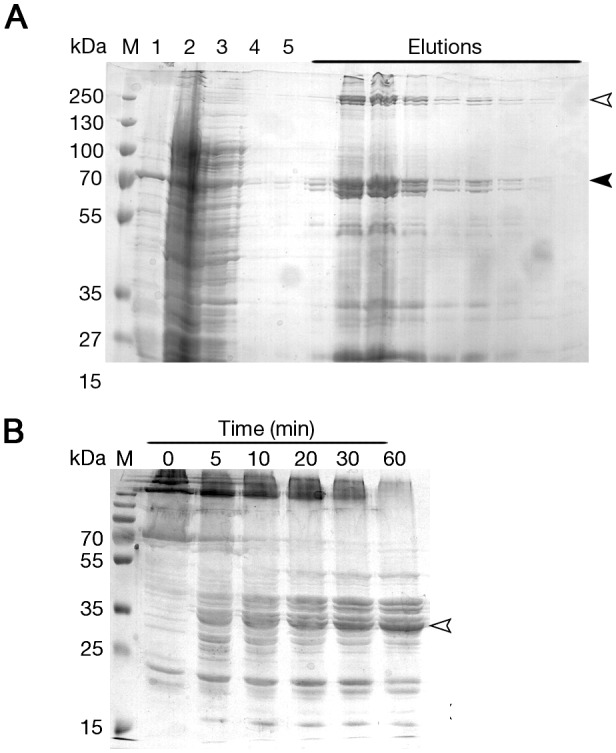
SDS-PAGE analysis of BteA purification and limited proteolysis experiments.(A) Ni2+-affinity chromatography purification of BteA showing fractions of: 1, pellet; 2, flow through; 3, wash 1; 4, wash 2; 5, wash 3; Elutions, selected elution fractions; M, marker. Black and white arrows indicate BteA monomer and oligomer respectively. (B) Limited proteolysis experiment was conducted on purified BteA after which the reaction was quenched by the addition of sample buffer and separated on 12.5% SDS-polyacrylamide.